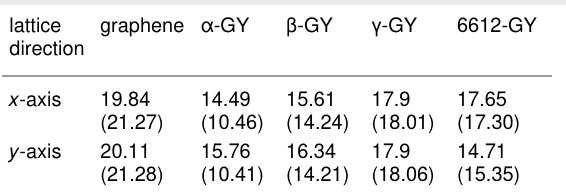
Figure 1. For graphene and α -GY, x- and y -axis are the zigzag and armchair lattice directions, respectively. The values in brackets are from theoretical calculations based on the reported Young’s modulus from literature